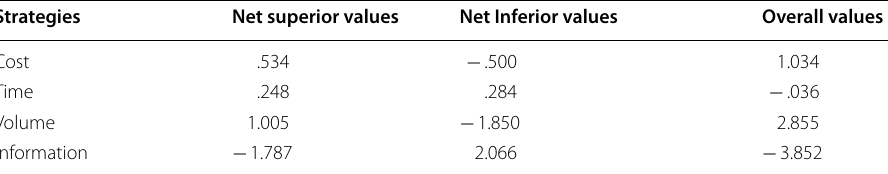
Table 18 Net superior, inferior, and overall values of the strategies Strategies